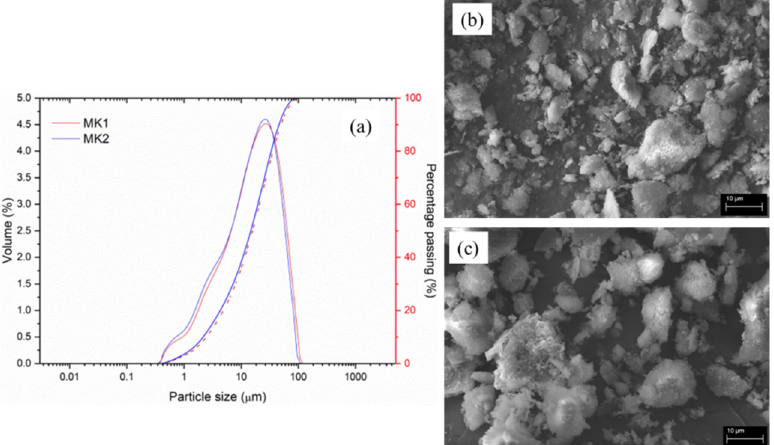
Table 1. Chemical compositions (% in mass) of MK1 and MK2.